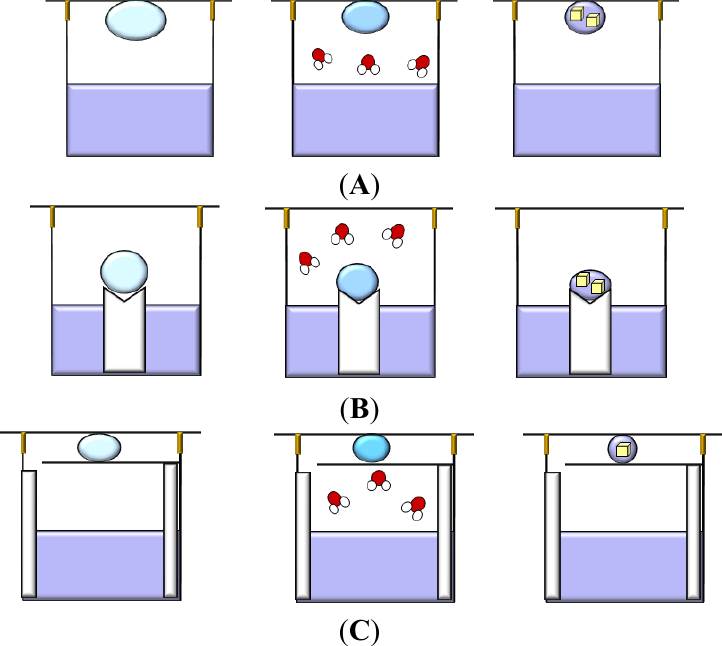
Figure 4. Vapor-diffusion method. A drop containing unsaturated precipitant and protein solution is placed in a well containing a reservoir with precipitant in higher